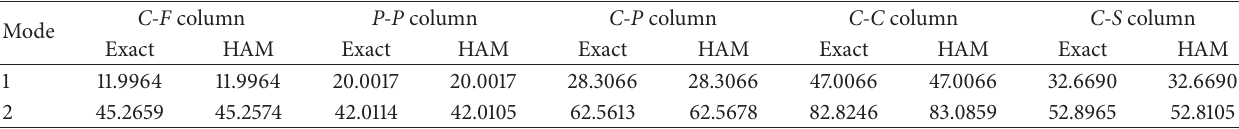
Table 4: Comparison of exact and HAM solutions of the buckling loads for 𝛽 = 100 with ten iterations.